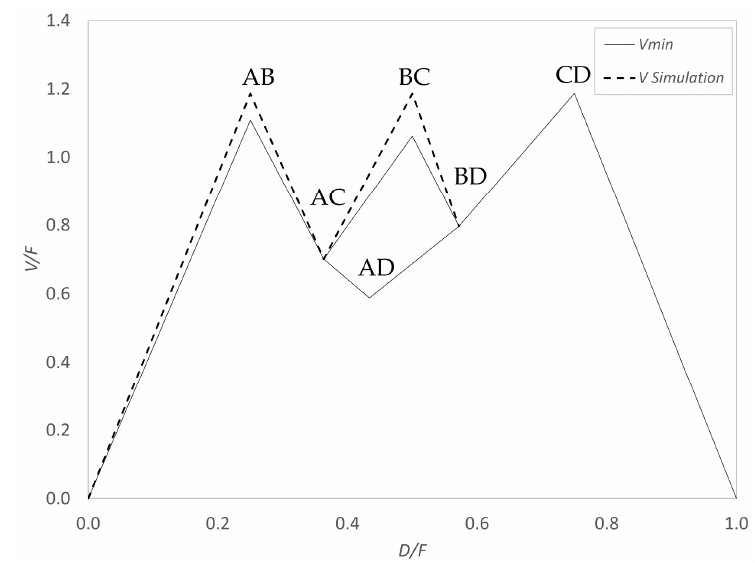
Figure 9. V min diagram of quaternary mixture of 3-Metylhexane (A)/Toluene (B)/Ethylbenzene (C)/1-Methyl-3-Ethylbenzene (D) ( z i = 0.25, q = 1). Dashed line indicates vapor streams implemented in simulation in Aspen Plus ® .